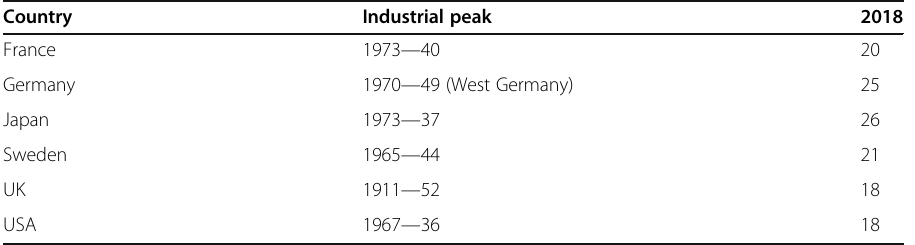
Table 1 Industrial employment (OECD definition, including manufacturing, construction, mining, and utilities) in some developed countries, from peak to 2018 (percent of total employment) Country Industrial peak 2018 France 1973 — 40 20 Germany 1970 — 49 (West Germany) 25 Japan 1973 — 37 26 Sweden 1965 — 44 21 UK 1911 — 52 18 USA 1967 — 36